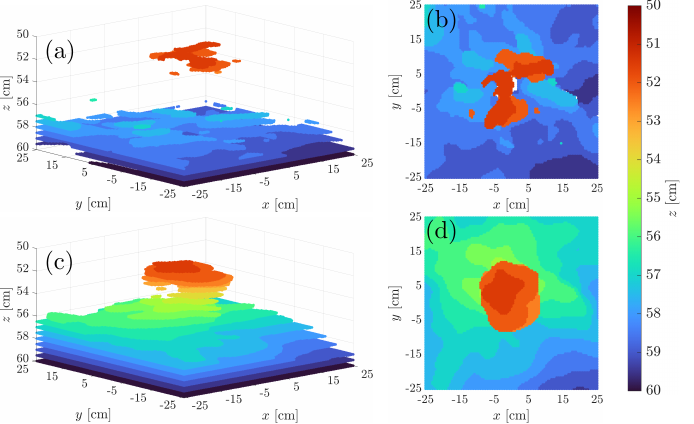
Figure 8. A comparison of the results of Kirchhoff migration ( a , b ) and diffraction stack ( c , d ) imaging, with ( a , c ) showing 3D visualizations and ( b , d ) showing a top-down view. Kirchhoff migration successfully localizes the LL logo, while the diffraction stack produces a smoothed